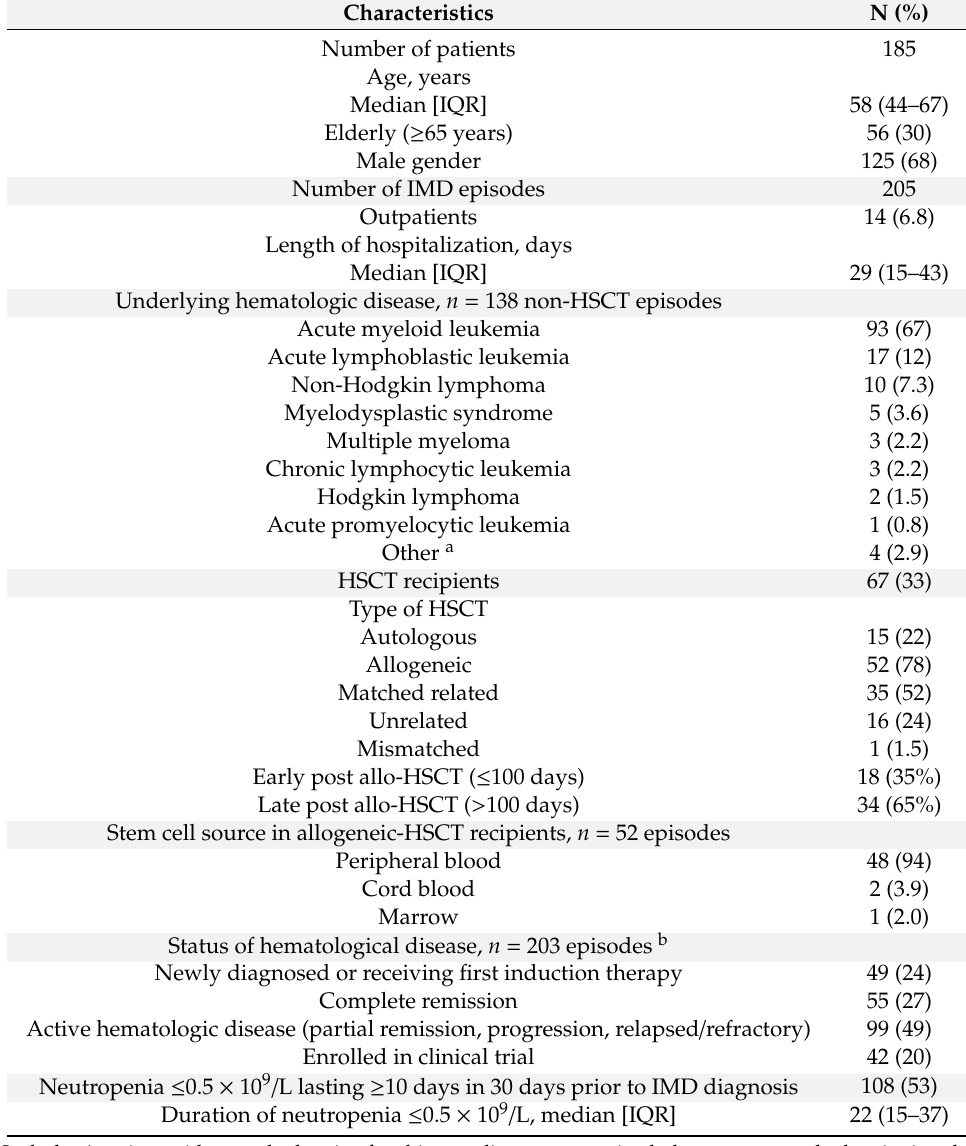
Table 1. Characteristics of patients with invasive mold